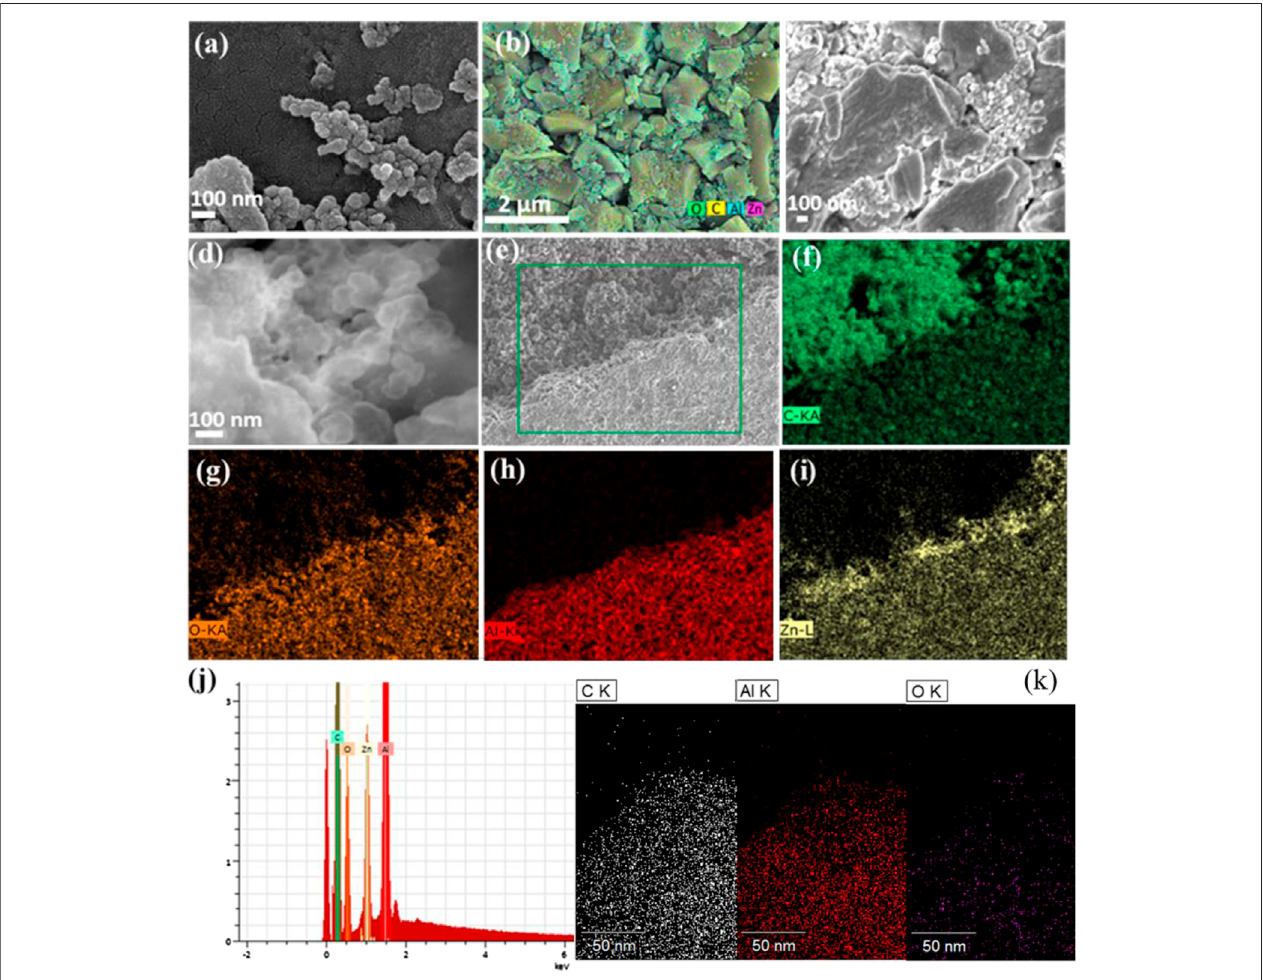
FIGURE 2 | SEM images of AC electrodes without coating (A) and coated with the ZnO-Al 2 O 3 mixture (B – D) . EDS elemental distribution of various elements in ZnO-Al 2 O 3 coating showing their presence at the bottom of AC electrodes (E – I) and its elemental mapping (J) . EDS elemental mapping of ALD Al 2 O 3 coated AC electrodes taken in TEM.